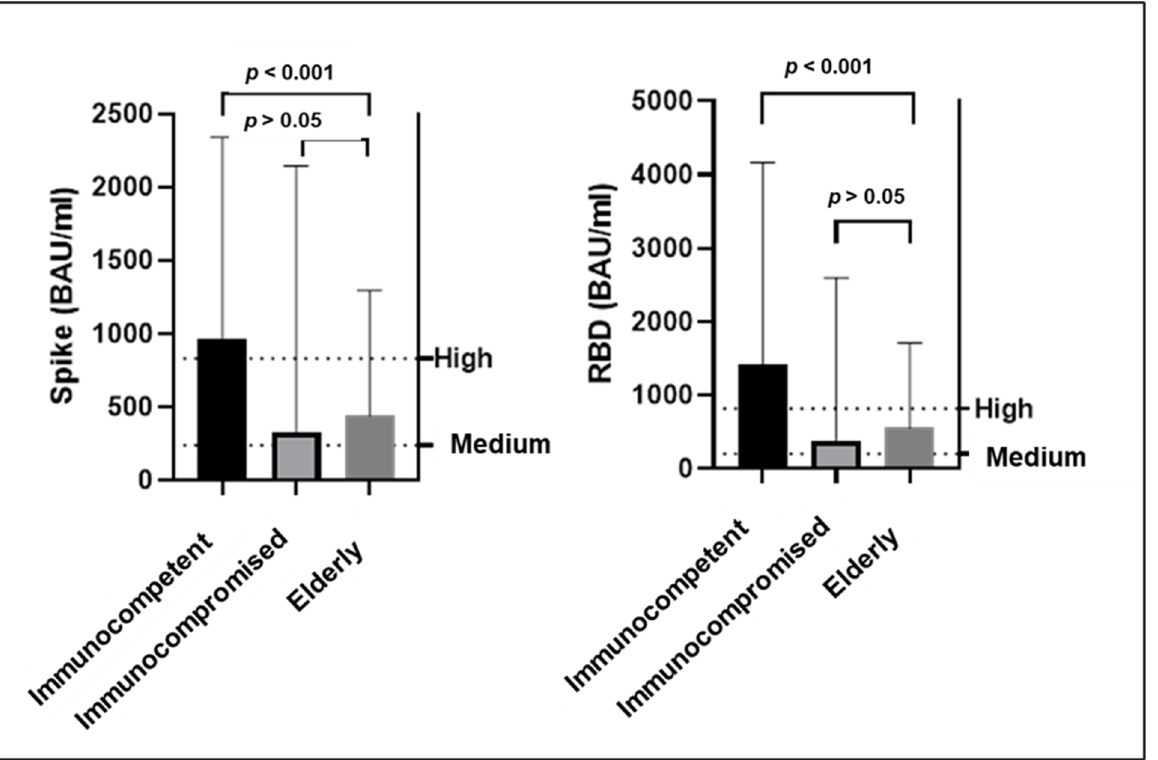
Figure 2. Median SARS-CoV-2 anti-spike and anti-RBD IgGs in immunocompetent, immunocompromised, and elderly patients experiencing a breakthrough infection. Medium and High lines indicate the WHO international standards for anti- SARS-CoV-2 immunoglobulins.